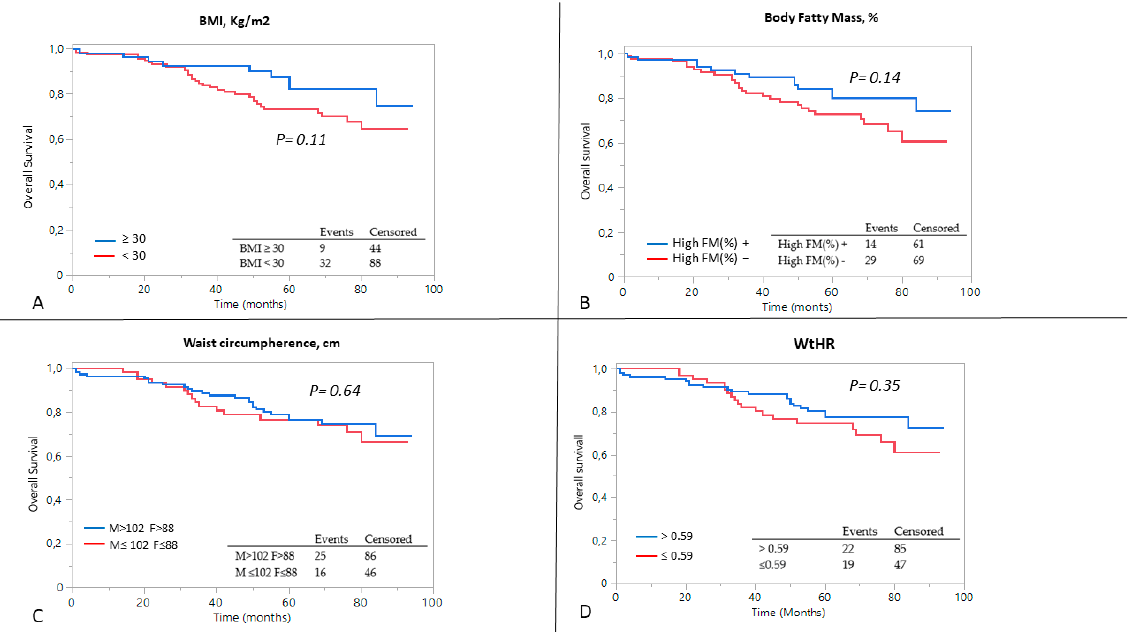
Figure 2. Kaplan–Meier curves for kidney outcome (ESKD) after dividing the patients on the basis of ( A ) BMI, ( B ) percentage of body fat mass, ( C ) waist circumference and ( D ) waist-to-height ratio. A log-rank analysis was conducted.